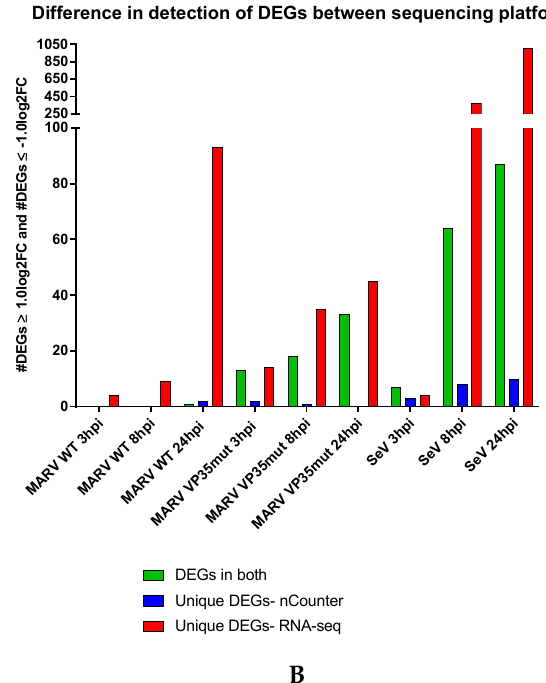
Figure 2. The shared DEGs between viruses within platforms and between platforms at each time point. ( A ) Numbers found in the center represent the total DEGs shared between all three viruses. The intersection of the green and yellow numbers represent the genes shared between SeV and MARV WT. The intersection of the blue and yellow numbers represent the genes shared between SeV and MARV WT. ( B ) The total number of DEGs in common for each transcriptomic platform are shown in green. The DEGs only found in the nCounter dataset are shown in blue. The DEGs only found in the RNA-seq dataset are shown in red.